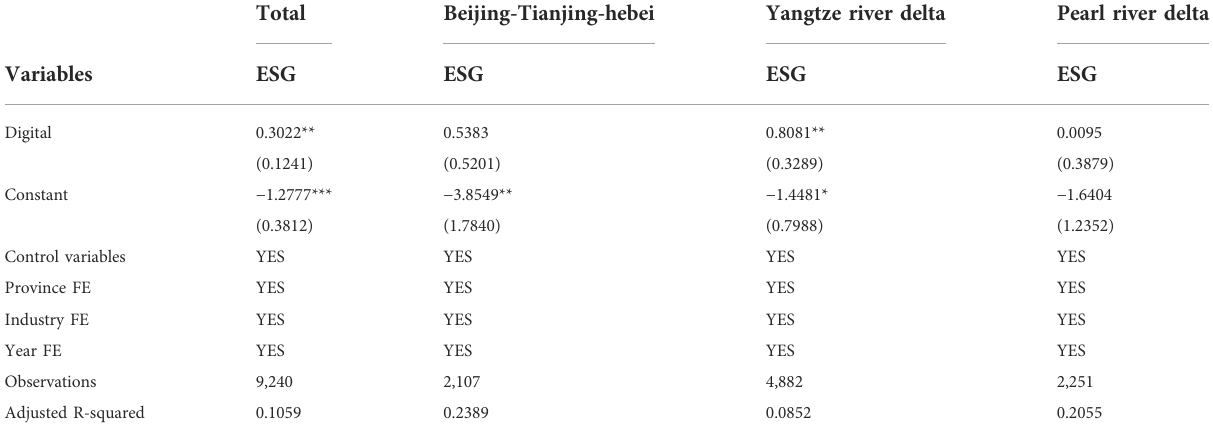
TABLE 6 Impact of digital economy development on ESG performance by distinguishing urban agglomerations.